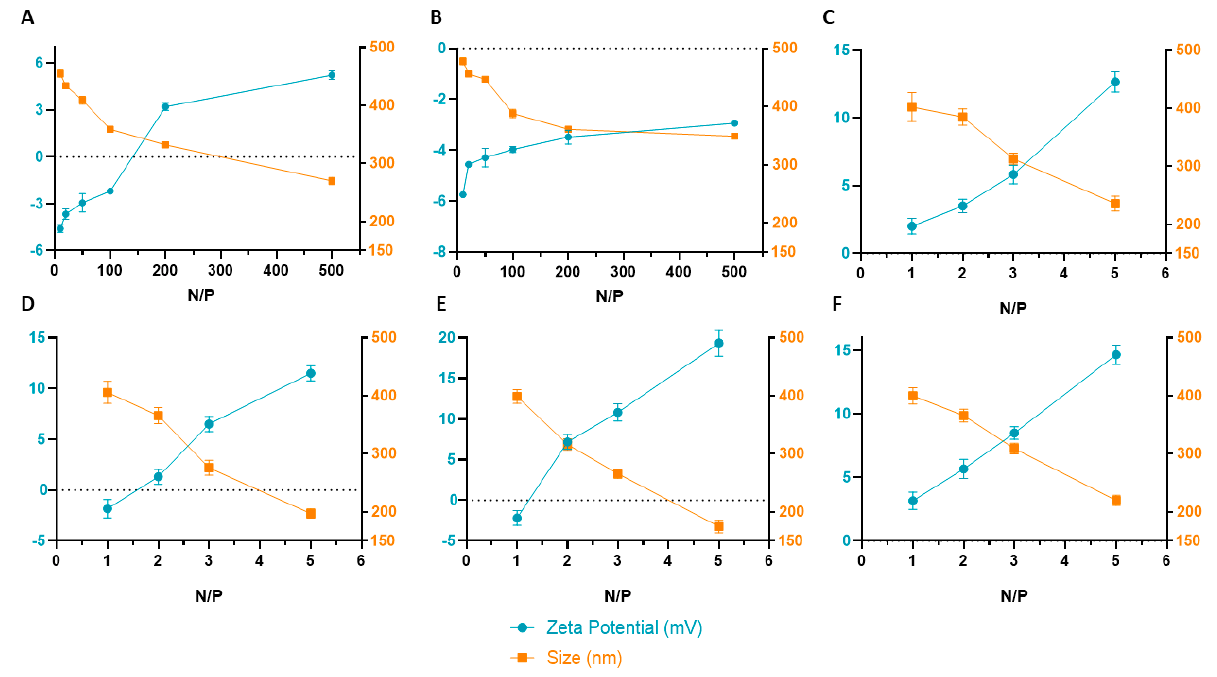
Figure 8. Average zeta potential and mean size displayed by PEI–DQA (10 kDa and 25 kDa)/TAT/pND1 ( A , B ), CpMTP/pND1 ( C ), MTS-WRAP1/pND1 ( D ), MTS-WRAP5/pND1 ( E ), and MTS-(KH) 9 /pND1 ( F )